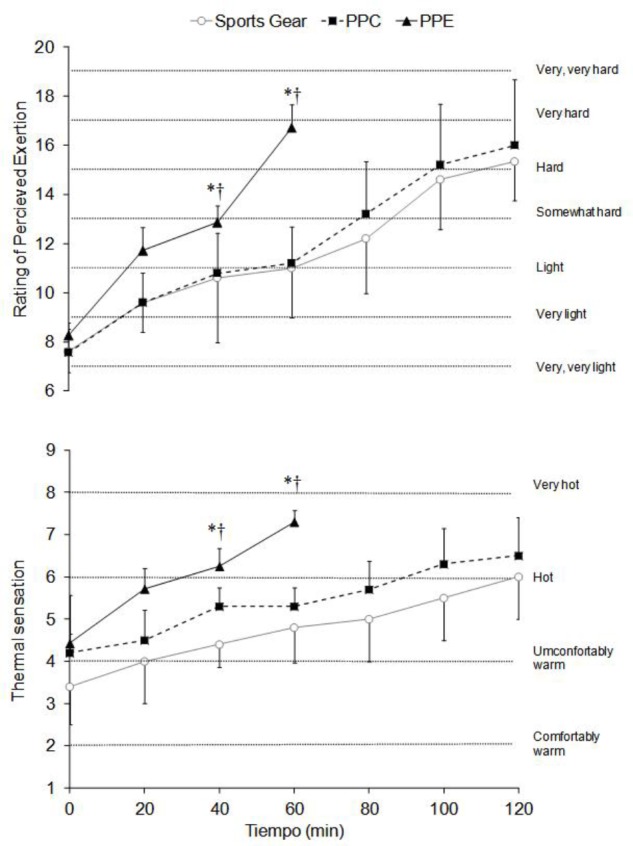
Rating of perceives exertion and thermal sensation wearing the short sports gear, the PPC and the PPE. Values are mean ± SD. †Differences with PPC (p < 0.05). ∗Differences with sports gear (p < 0.05).